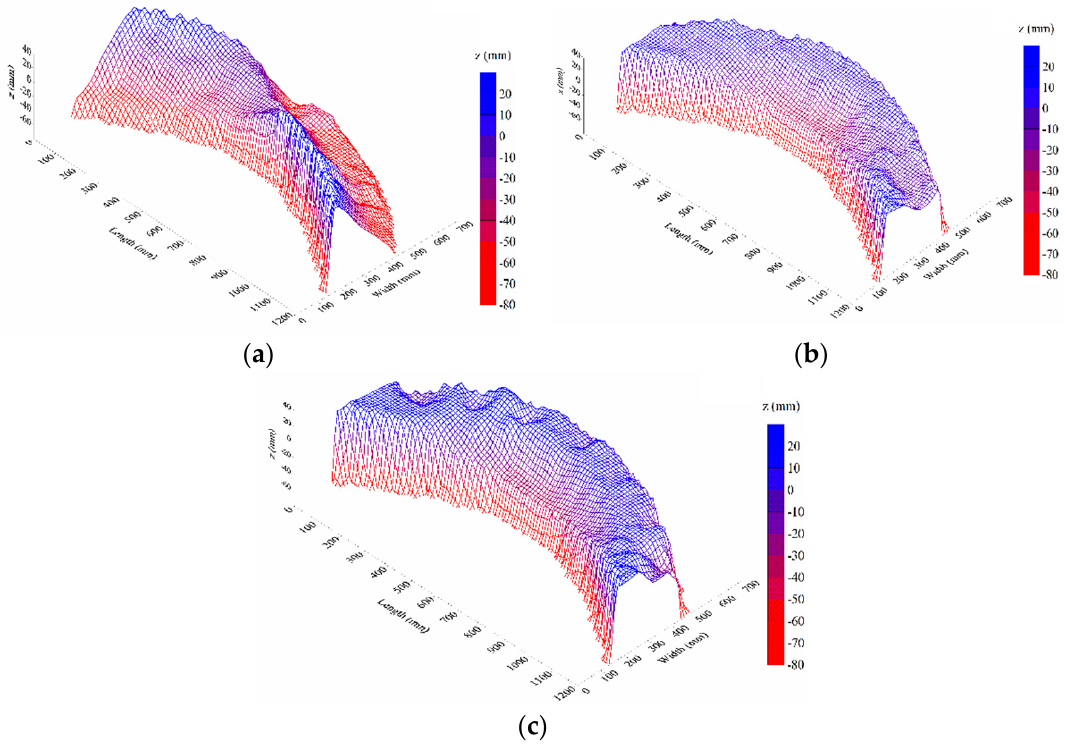
Figure 3. Bed topography along the bend, ( a ) without cylindrical rods (Test 1), ( b ) Model SR (Test 2) and ( c ) Model DR (Test 3), z = 0 corresponds to the initial bed level.